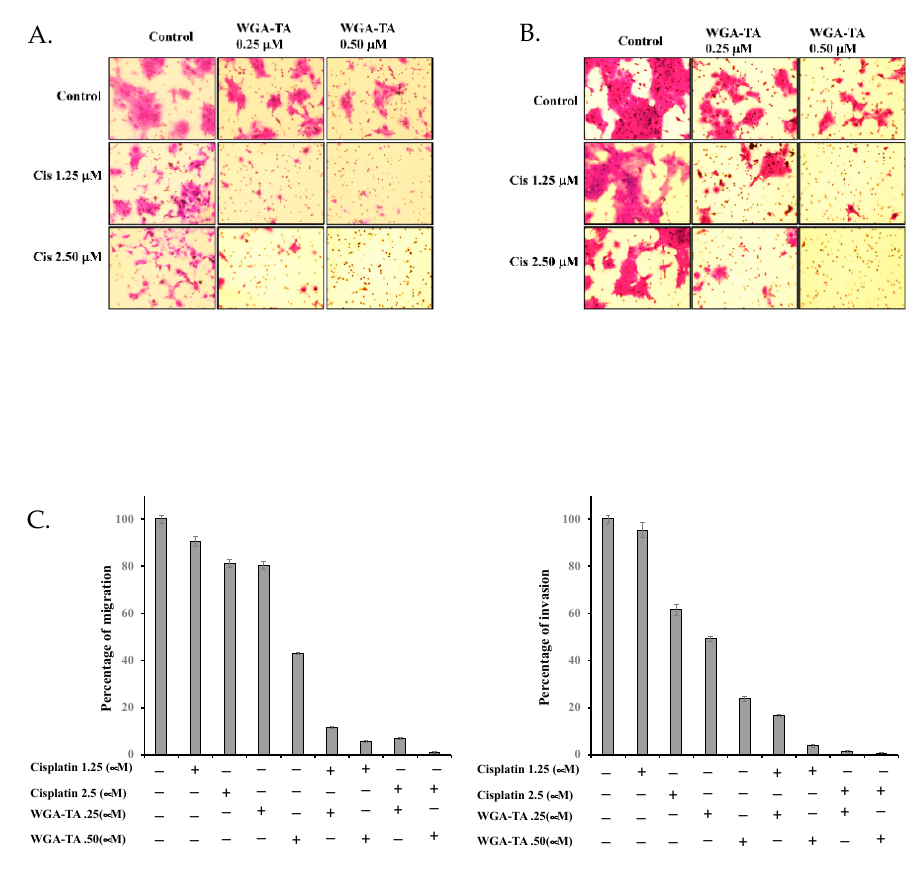
Figure 6. ( A , B ) The Boyden chamber assay utilized approximately 100,000 MDA-1986 cells treated with either 1.25 or 2.5 µ M cisplatin alone or in combination with 0.25 or 0.50 µ M WGA-TA for 24 h. Control inserts were used for migration ( A Left ) and Matrigel coated inserts were used for invasion ( B Right ). Post-treatment, the cells were fixed with 2% paraformaldehyde, stained with 1% crystal violet in 20% methanol, washed and imaged using a light microscope. Quantification for the migration and invasion are given below ( C ).